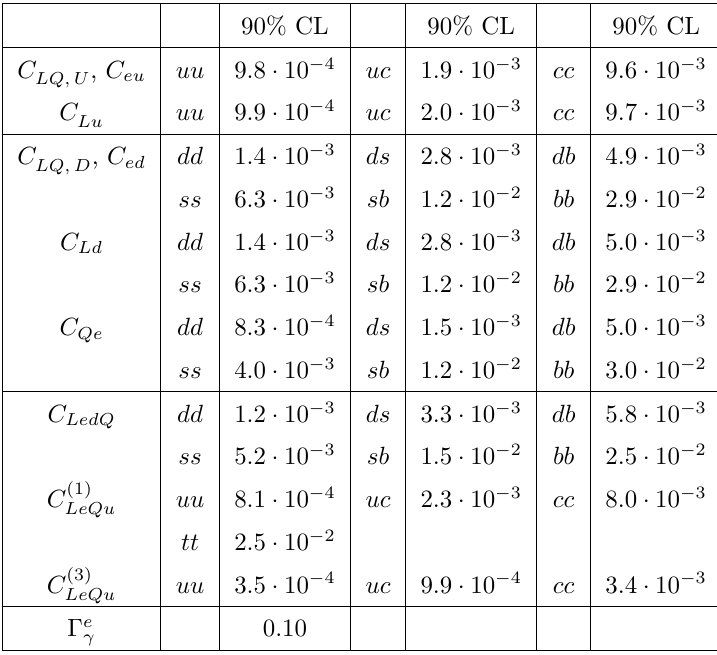
Table 8 . 90% CL bounds on four-fermion LFV operators from the LHC. The coefficients are evaluated at the scale µ = 1 TeV. For quark-flavor-changing operators, the bounds on the q q i q j components are